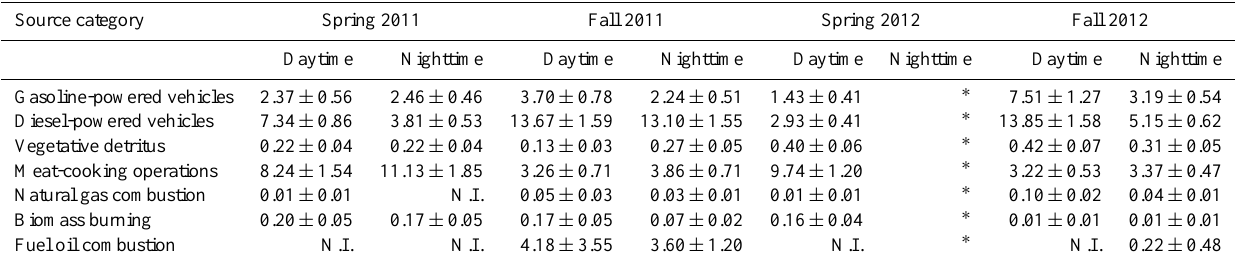
Table 5. Contributions and uncertainty of primary sources to seasonal average ambient PM 2 . 5 for daytime and nighttime in the MMA (in µgm − 3 )